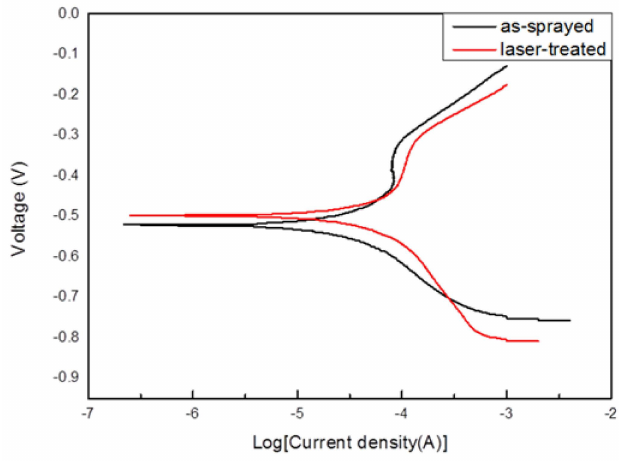
Figure 7. Potentiodynamic polarization scans for FeCrAl plasma spray-coated Mo alloys in 3.5% NaCl solution with and without the post-laser treatment.